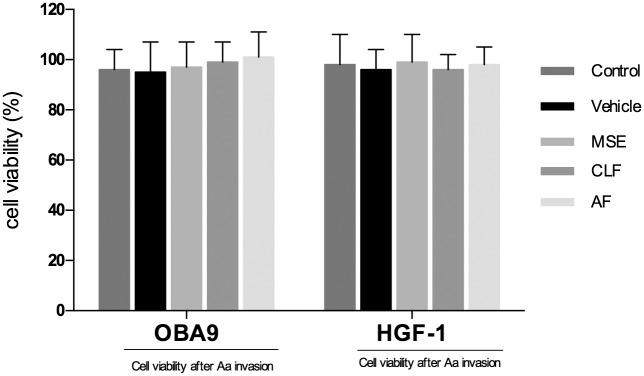
Cytotoxicity effect in the dual chamber model.Cytotoxic effects of MSE, chloroform and aqueous fraction on fibroblast HGF-1 and keratinocyte OBA-9 cell lines were found after 24 h hours of invasion by A. actinomycetemcomitans. Data are expressed as mean ± SEM using one-way analysis of variance (ANOVA) followed by Dunnet’s multiple comparison tests as compared to the control group (non-treated). The level of statistical significance was set at 0.05.